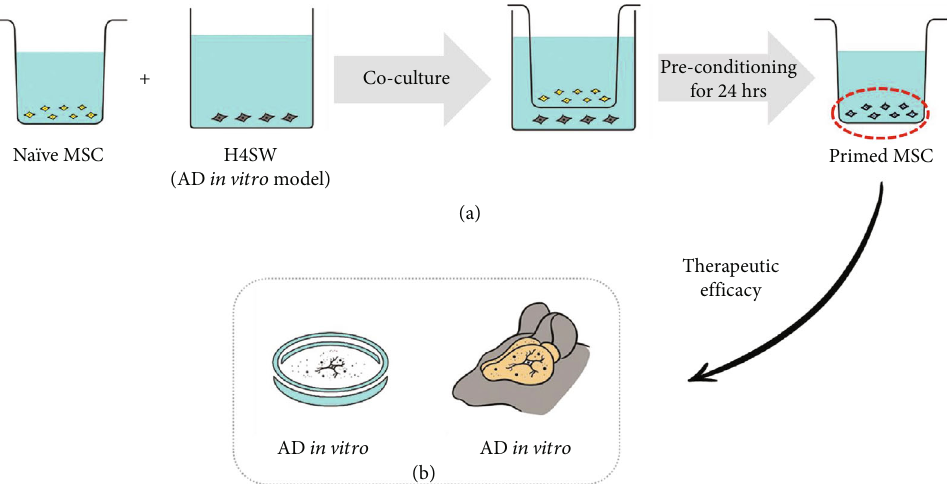
Figure 1: The concept of primed MSCs. (a) The procedure for preconditioning WJ-MSCs with H4SW cells to make primed MSCs. (b) After preconditioning, the therapeutic e ffi cacy of primed MSC was evaluated in vitro and in